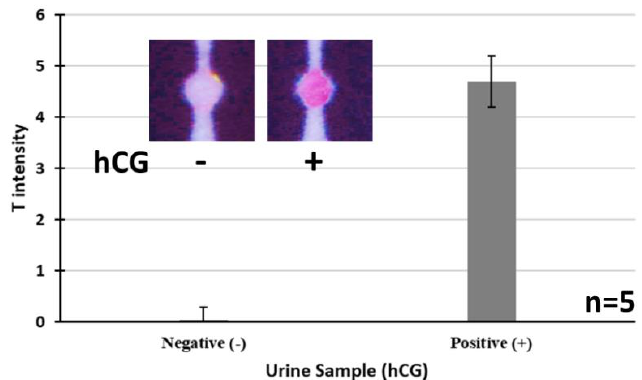
Figure 7. Response of the developed assay to real urine samples acquired from semi-quantitative image analysis. The error bars represent the standard deviations corresponding to the average values. Photographs of the used µPADs for real sample tests are also shown in the inset, indicating the negative and positive signals.